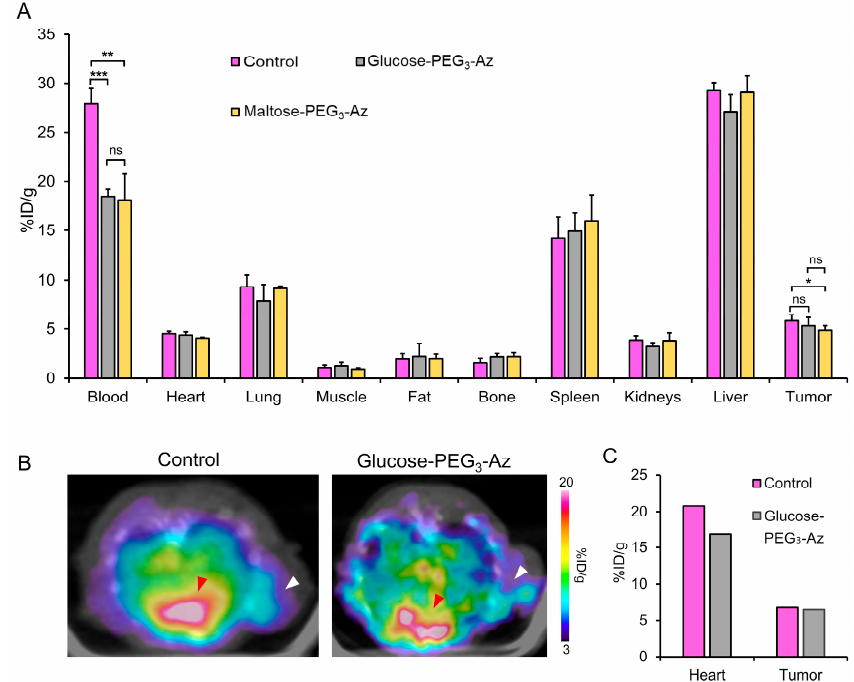
Figure 8. SPECT and Biodistribution study in female nude mice bearing NIH3T6.7 tumors at 7 h postinjection of [ 131 I] -DPTA-trastuzumab. Biodistribution ( A ). SPECT images (n = 1 each); Control and glucose-PEG 3 -azide ( B ), and quantification data of glucose-PEG 3 -azide ( C ). The red arrowhead indicates the heart, whereas the white arrowhead indicates tumor. ns represents not statistically significant. * p < 0.05, ** p < 0.01, and *** p < 0.001.